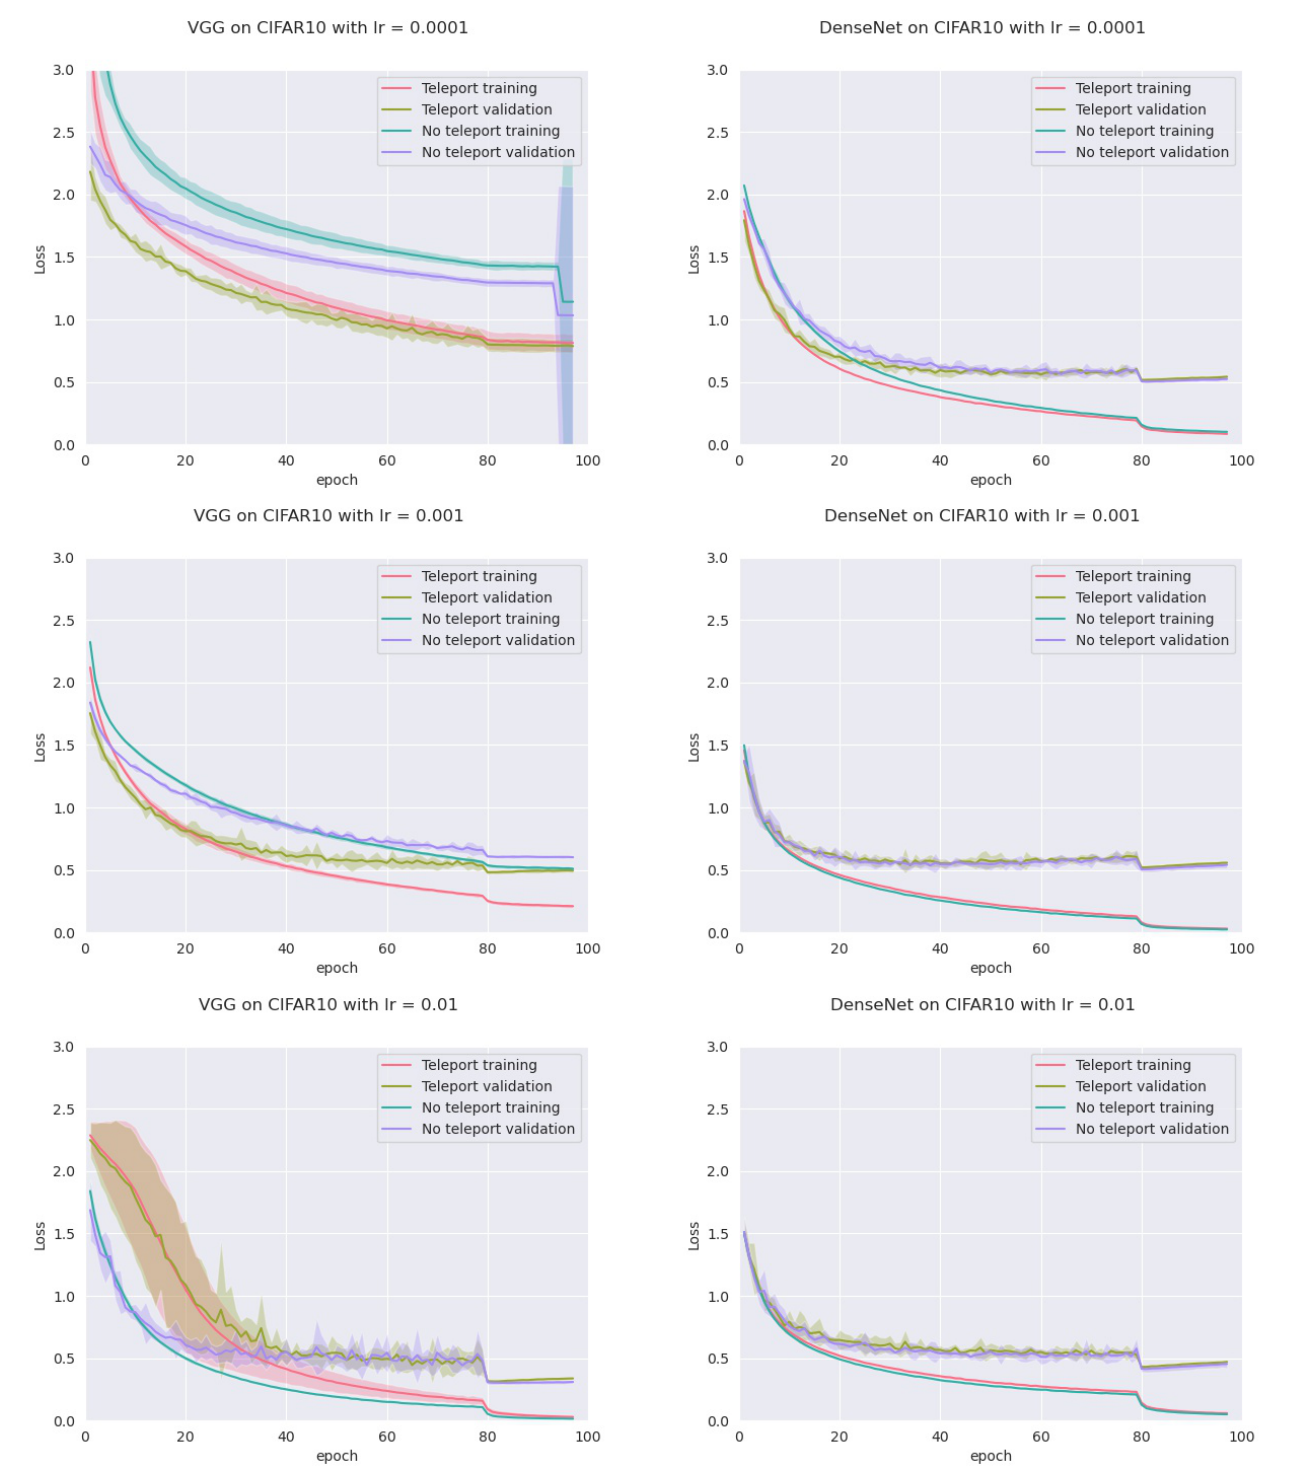
Figure A11. Average loss of MLP with normal initialization on CIFAR100 ( left ) and DenseNet with Xavier initialization on CIFAR10 ( right ) both traing with SGD over 5 experiments for each, with and without teleportation, at the beginning of the training with CoB of 0.9. Learning rate increases from top to bottom rows. We also show a shadow around the average curves at two times the standard deviation over the five